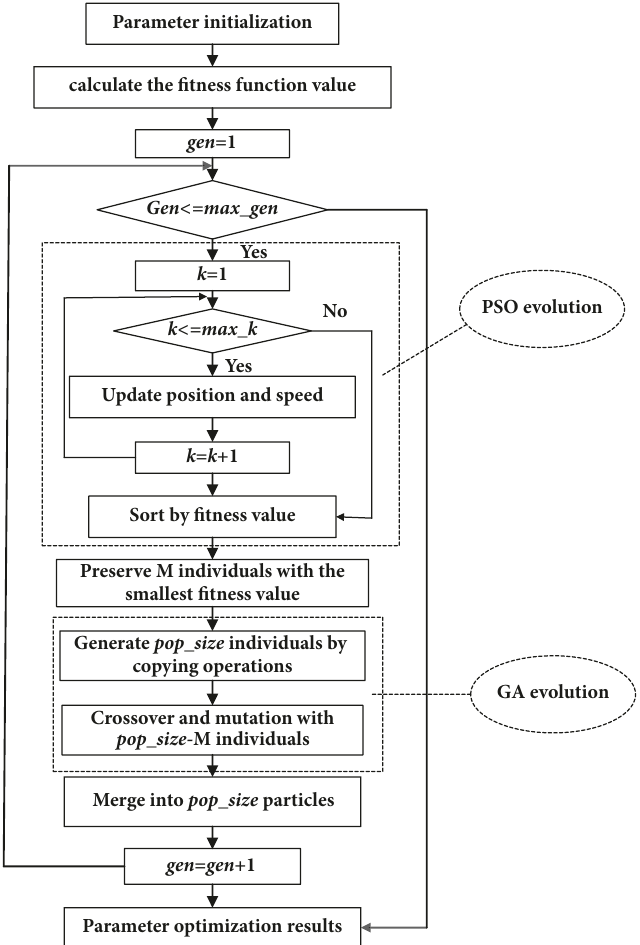
Figure 2: The process of GA-PSO hybrid optimization